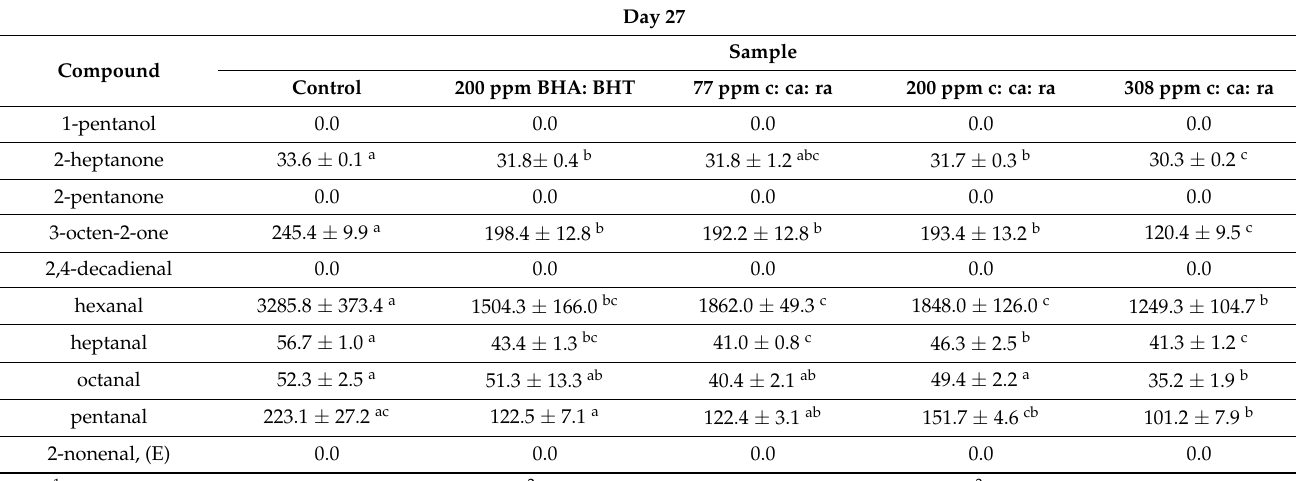
Table A7. Levels of volatile compounds ( µ g/kg of FFMP) as measured with HS-SPME-GC-MS analysis in FFMPs with or without antioxidants, after accelerated storage (40 ◦ C, RH 23%) for 27 days 1, 2, 3, 4 .